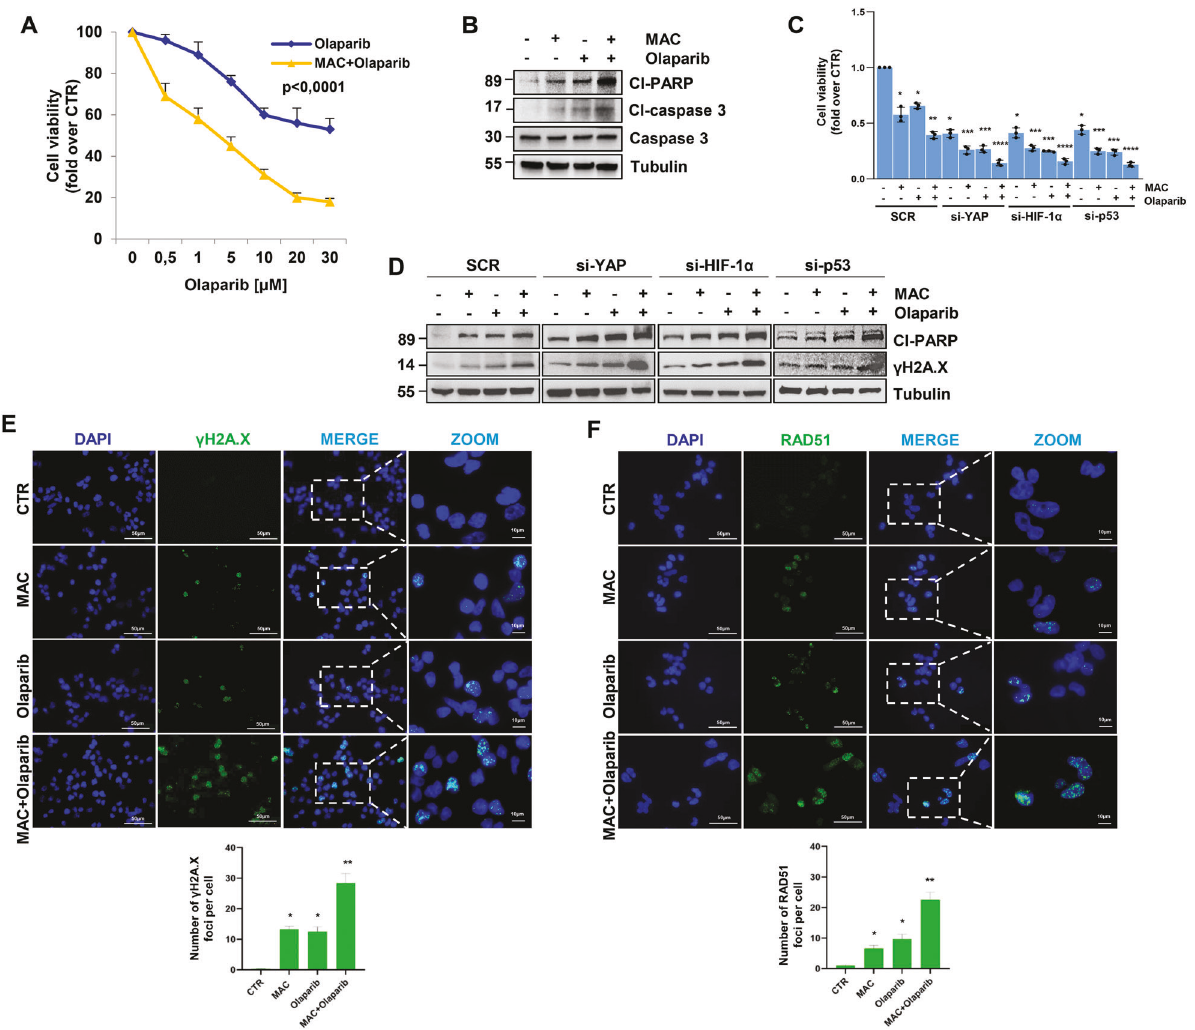
Fig. 6 ET-1R blockade by macitentan, hampering the mutp53/YAP/HIF-1 α axis, enhances HG-SOC cell sensitivity to olaparib, promoting DNA damage and apoptosis. A Effect of different concentrations of olaparib, alone or in combination with MAC (1 µM) for 48 h, on PMOV10 cell vitality. Data points are means ± SD (* p < 0.0001 vs. olaparib; n = 3). B IB analysis of cleaved-PARP (cl-PARP), caspase 3 and cleaved-caspase 3 (cl-caspase 3) expression in PMOV10 cells treated with MAC and/or olaparib (1 µM). Tubulin represents the loading control. C Effect of treatment with MAC and/or olaparib, alone or in combination for 48 h, on the vitality of PMOV10 cells transfected with SCR, si-YAP, si-HIF-1 α or si-p53 for 72 h. Bars are the means ± SD (* p < 0.0005 vs. SCR CTR; ** p < 0.002 vs. SCR olaparib; *** p < 0.002 vs. SCR olaparib or SCR MAC; **** p < 0.0006 vs. SCR MAC + olaparib; n = 3). D IB analysis of cleaved-PARP and phospho-Histone H2A.X (S139; γ H2A.X) expression in PMOV10 cells treated as in C. Tubulin represents the loading control. Representative images of blots of 3 independent experiments are shown in B and D . E , F Representative images of γ H2A.X ( E ) and RAD51 ( F ) foci (green) evaluated by IF in PMOV10 cells stimulated with MAC and/or olaparib for 24 h (scale bar: 50 µm, magni fi cation 64X). Nuclei are stained blue (DAPI). Images are magni fi ed to show the γ H2A.X ( E ) and RAD51 ( F ) foci. The bottom graphs represent the quanti fi cation of the number of γ H2A.X and RAD51 foci. Bars are means ± SD (* p < 0.005 vs. CTR; ** p < 0.005 vs. olaparib ; n =